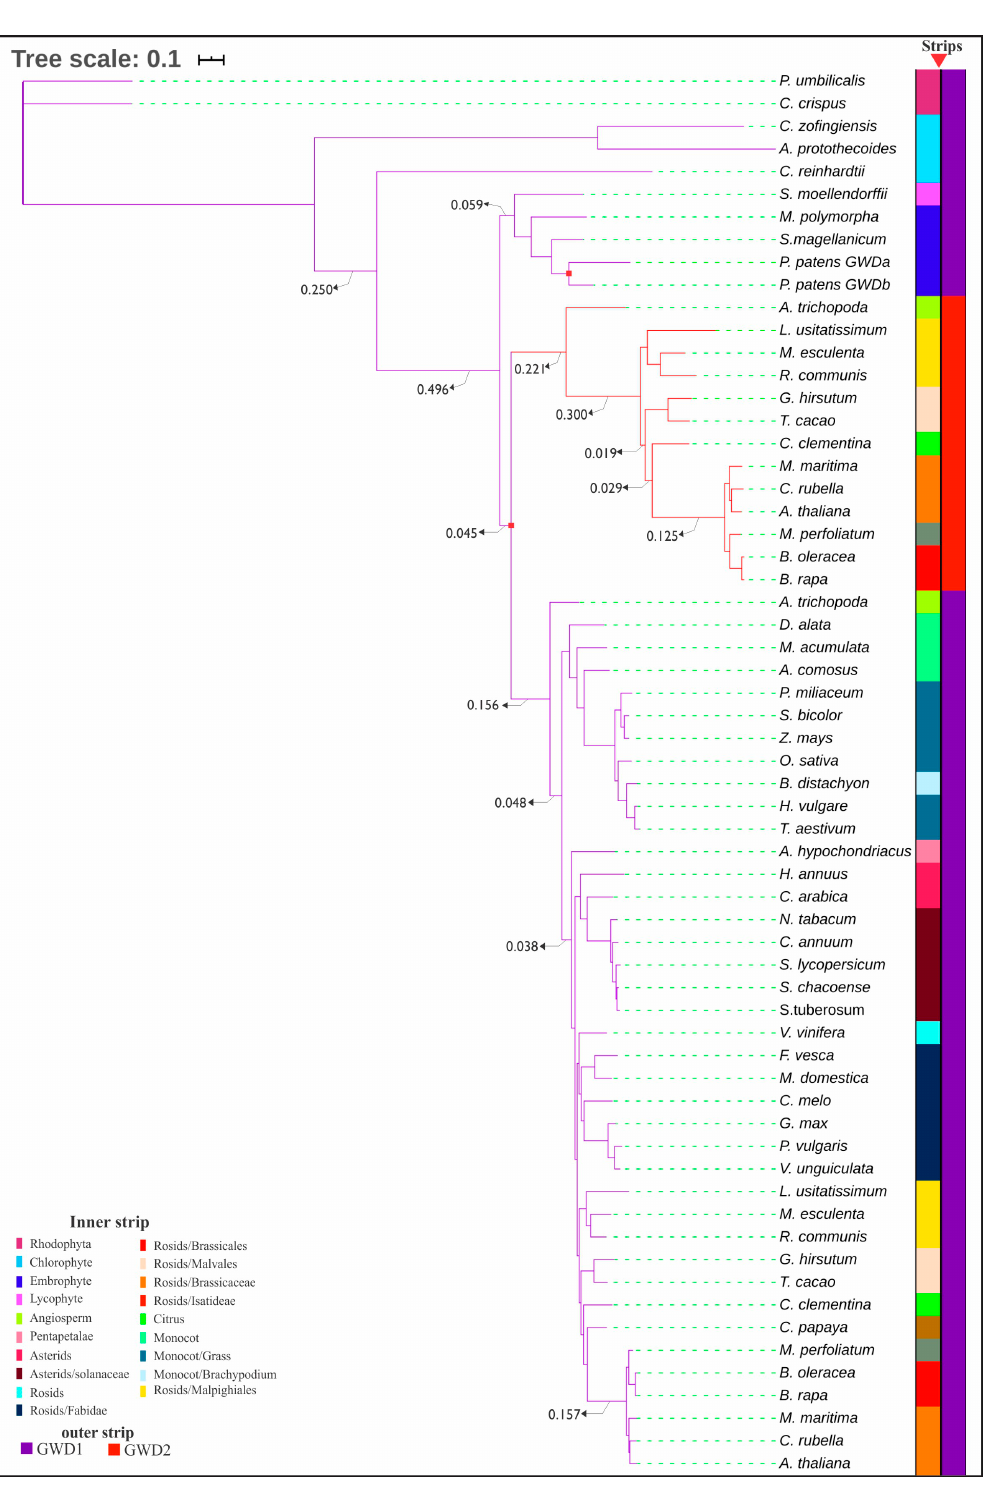
Figure 1. Evolutionary relationship among the taxa as shown by the phylogenetic tree. We used block mapping and gathering with entropy (BMGE) for trimming MSA of GWD protein sequences. For tree inference (PhyML + SMS), default setting for statistical model, tree topology search and branch support was used. The scale represents amino acid substitution per site. Duplication of ancestral alpha-glucan water dikinase (GWD) in P. patens to GWDa and GWDb, as well as GWD1 and GWD2 in angiosperms are indicated with red squares at the respective